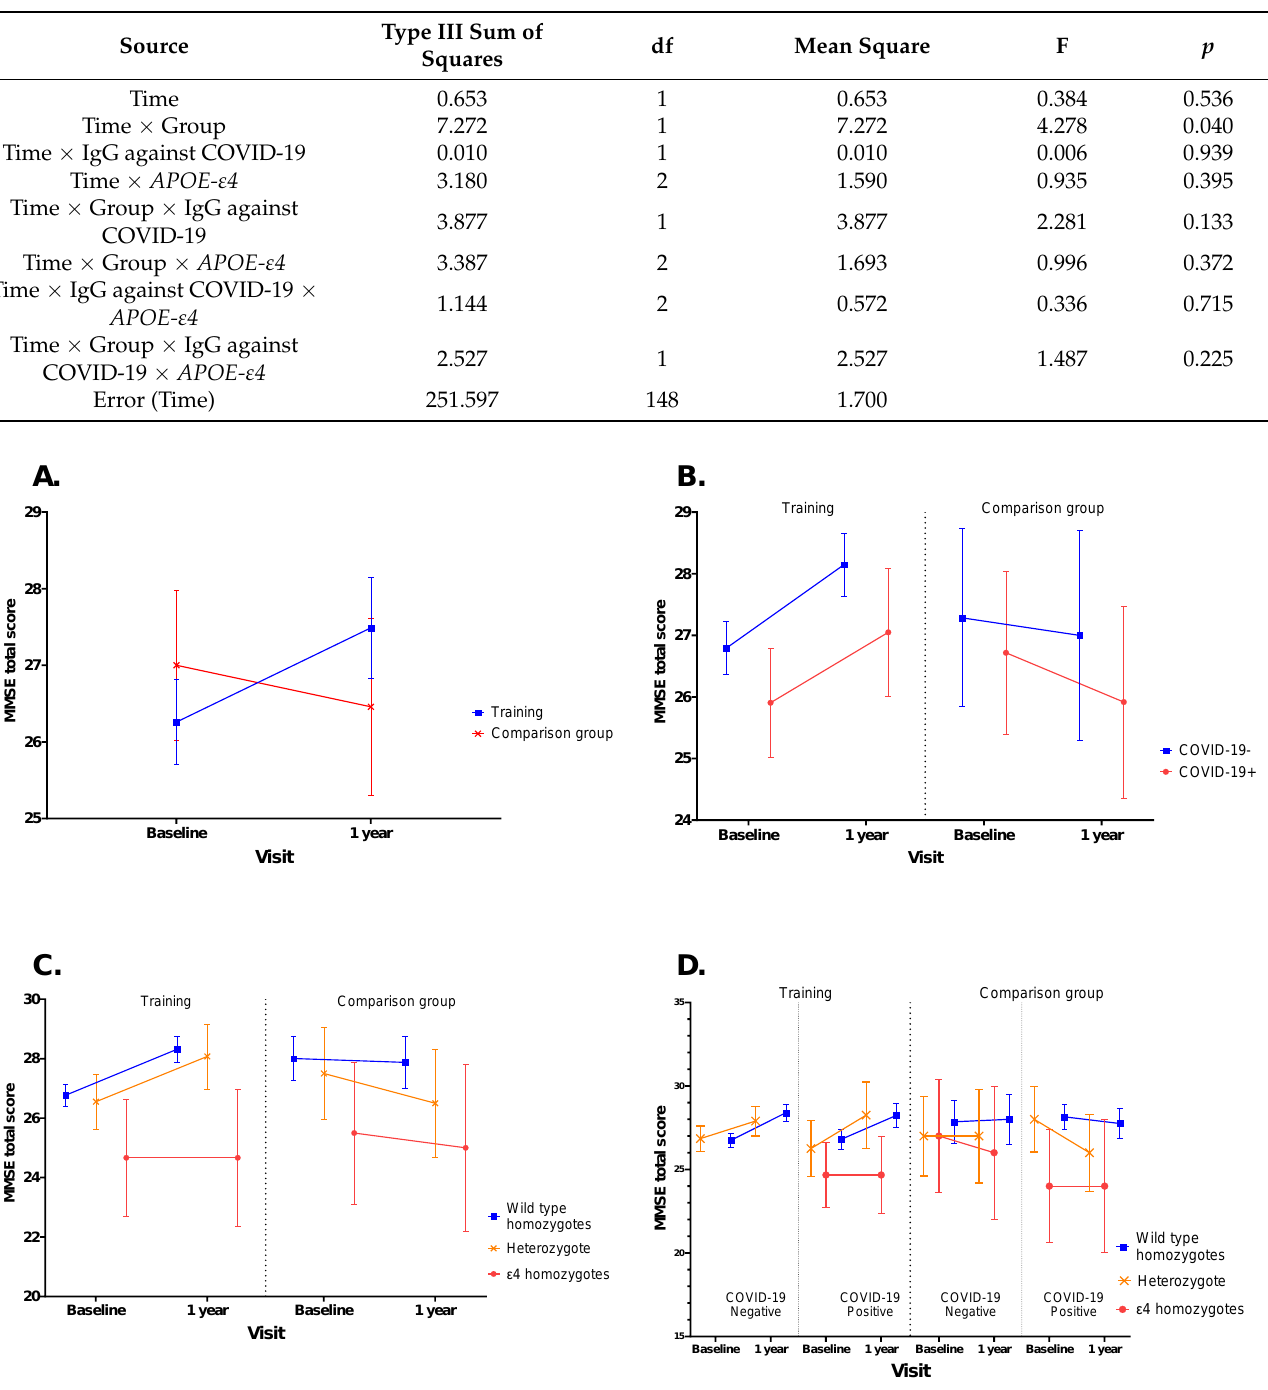
Figure 2. Marginal mean MMSE total score changes for repeated-measures ANOVA for ( A ) time × group interaction, ( B ) time × group × anti-COVID-19 IgG status, ( C ) time × group interaction, ( B ) time × group × APOE ε4 genotype, ( D ) time × group × anti-COVID-19 IgG status × APOE ε4 genotype. Note: p -levels are provided for within-group comparisons.